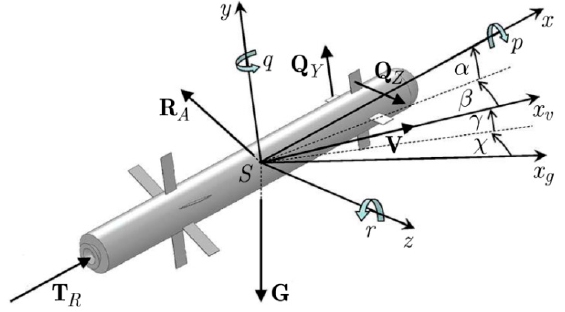
Figure 1. Force system acting on the ATGM within the gravitational field and Earth’s atmosphere together with the accepted coordinate systems.